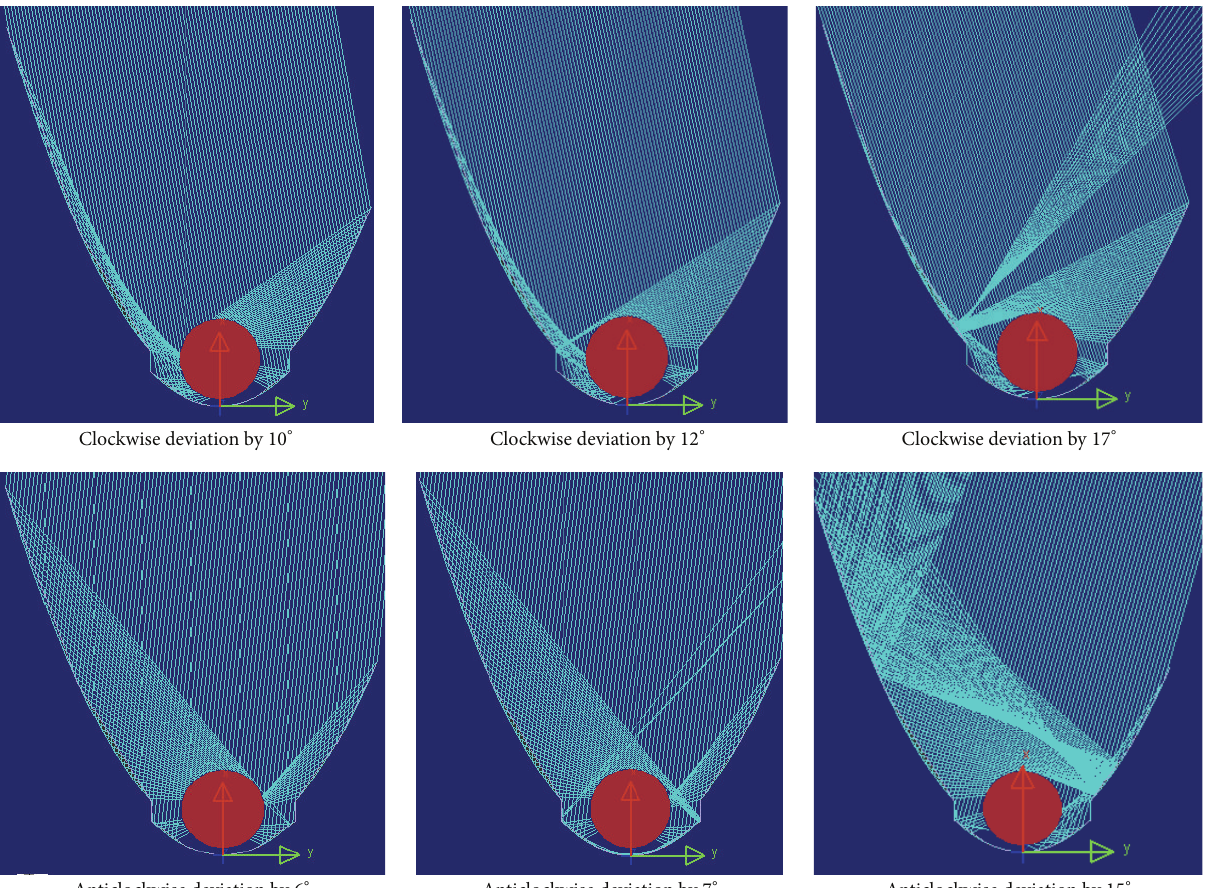
Figure 4: Ray-tracking for various deviation angles of the